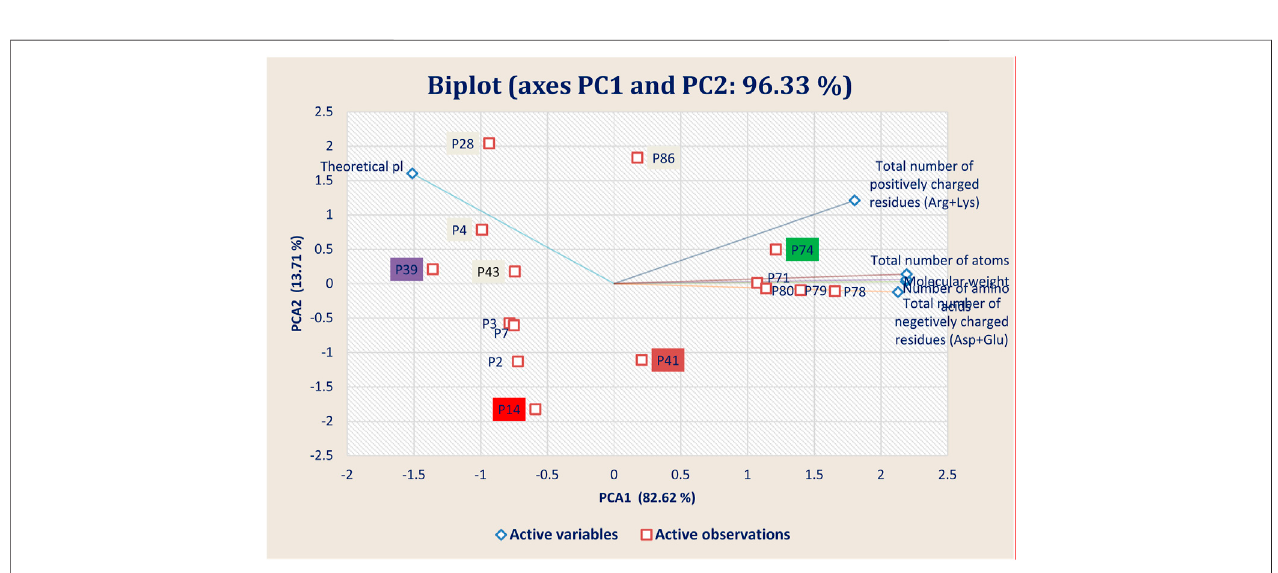
Frontiers in Molecular Biosciences |